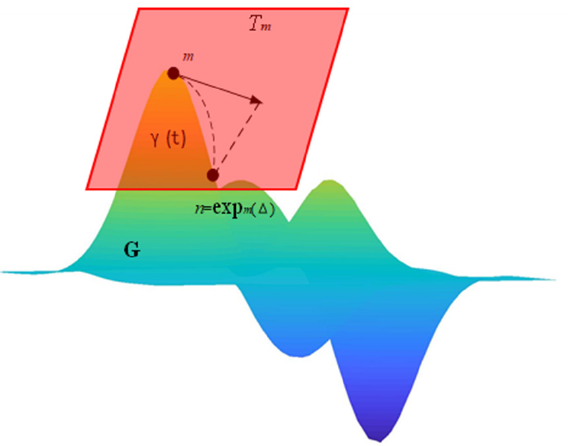
Figure 1. Visualization of 2-D manifold G embedded in R 3 . T m is the tangent plane at point m, and γ ( t ) is the geodesic distance between any two points m and n on the manifold space.